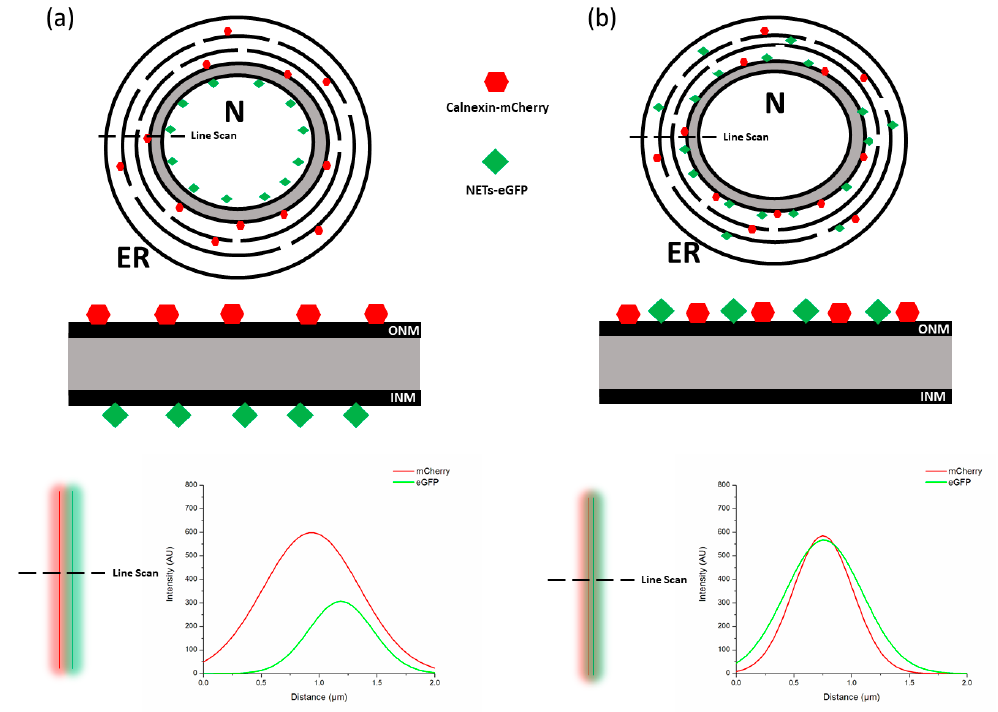
Figure 3. A model of differential staining using Airyscan confocal microscopy. ( a ) Calnexin tagged with mCherry (red) localizes exclusively to the ONM and ER. While the NETs of interest tagged with GFP (green) is enriched at the INM. A line scan is performed and a line profile is generated indicating that the two fluorophores do not co-localize. ( b ) A line scan of NETs tagged with GFP (green) that are enriched at the ONM and ER do co ‐ localize with calnexin .